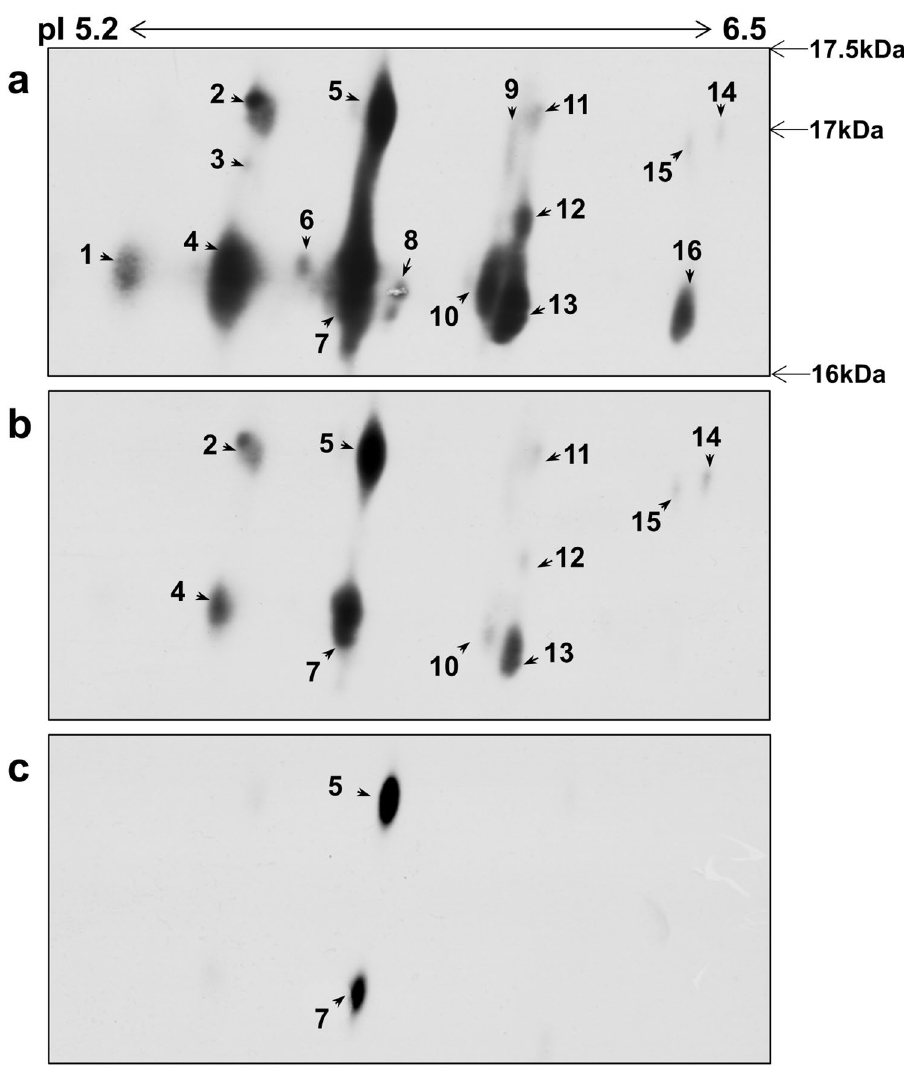
Figure 7. Expression of MUP isoforms in kidneys of rats exposed to TAA using the 2-DE immunoblot Assay. The expression of MUP isoforms was identified by the 2-DE immunoblot assay in the kidneys of rats exposed to TAA. MUP isoforms were separated by 2-DE using pH 4–7 NL (24 cm) strips and 11.5% SDS-PAGE ( a control group (0.5% carboxymethyl cellulose vehicle only), b 10 mg/kg BW TAA, and c 30 mg/kg BW TAA). Proteins (pI range from 5.2 to 6.5; MW from 16 to 17.5) were electroblotted onto PVDF membranes (20 × 14 cm). Sixteen isoforms were found to be downregulated with exposure to increasing TAA